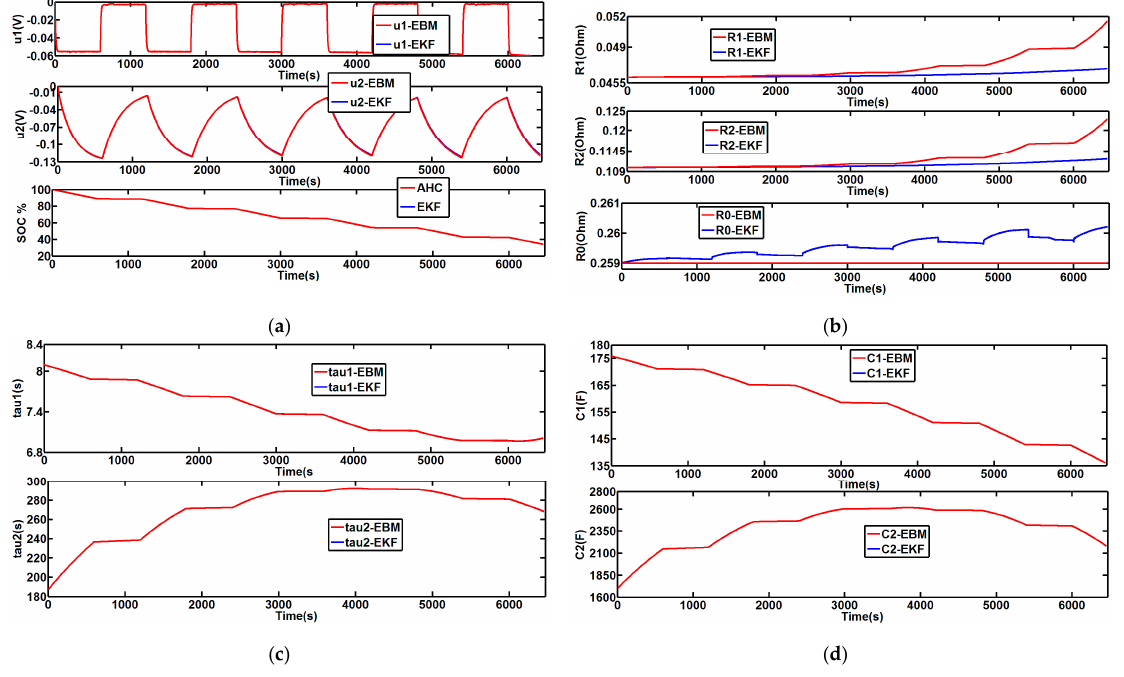
Figure 13. Comparison of EBM and EKF results for the 1.2 A current profile ( a ) plot of u 1 , u 2 and SOC, ( b ) resistances R 1 , R 2 and R 0 ( c ) time constants τ 1 and τ 2 ( d ) capacitances C 1 and C 2 .